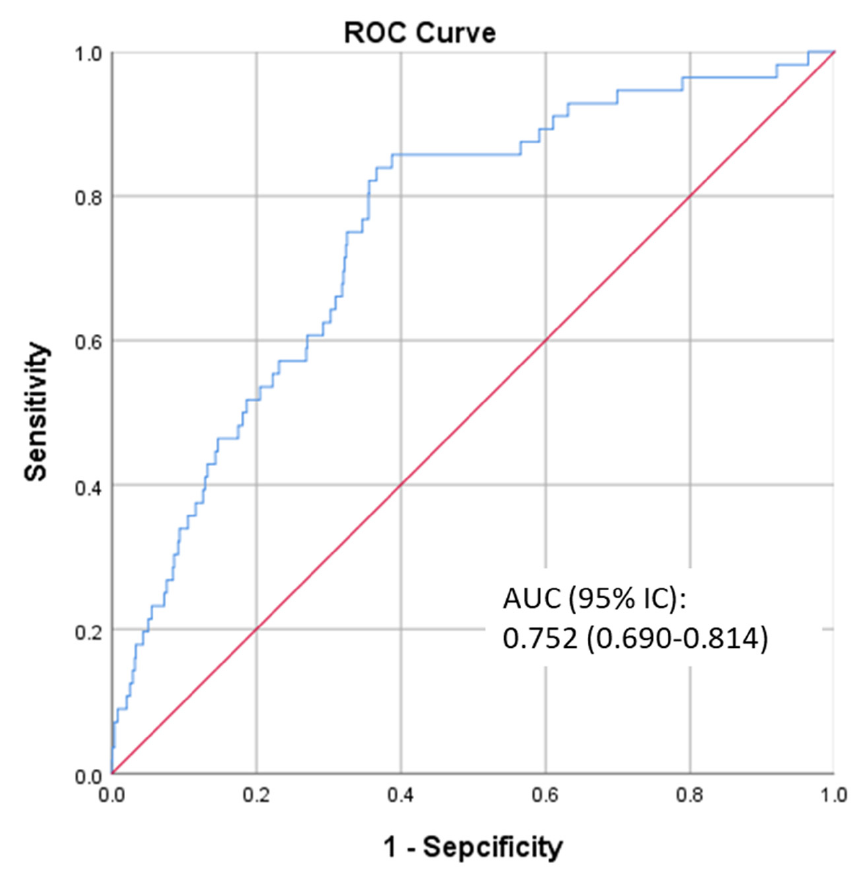
Figure 2. The ROC of the prediction model. Abbreviations: ROC, receiver operating characteristic curve; AUC, area under the curve.